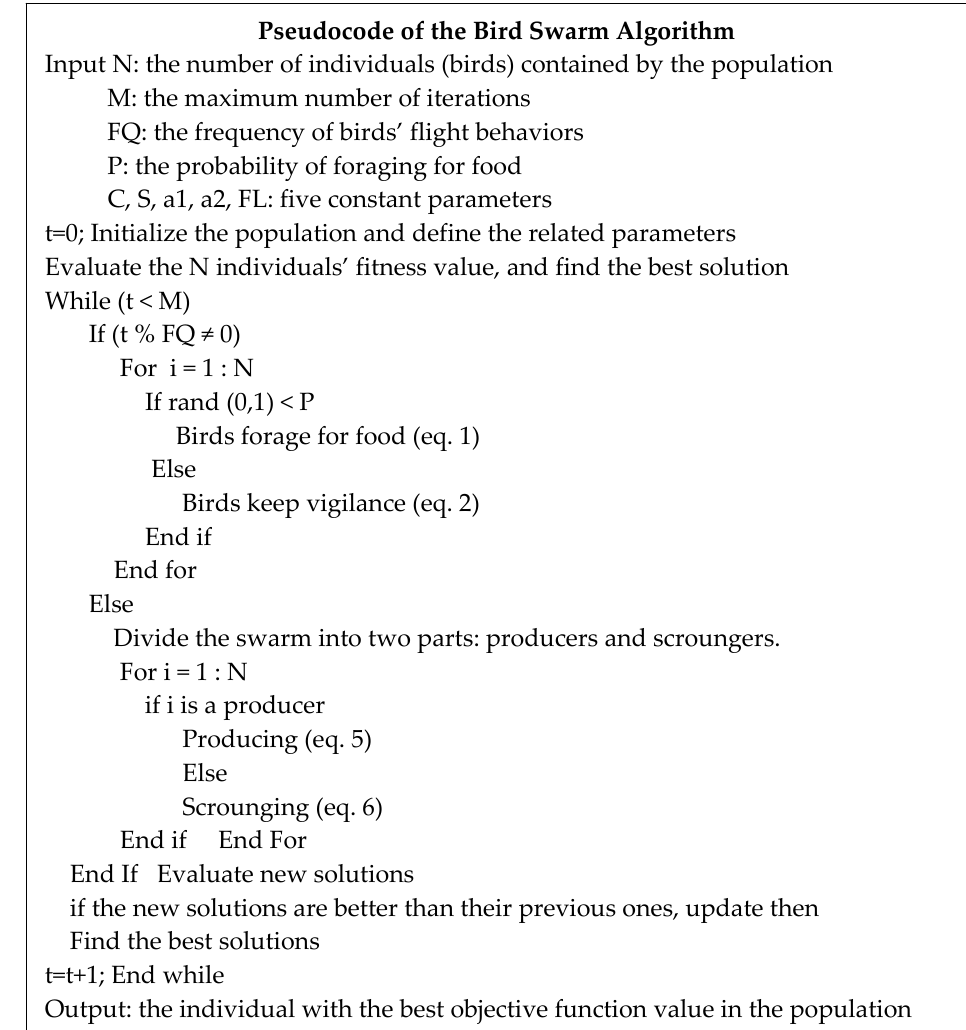
Figure 1. BSA pseudocode.